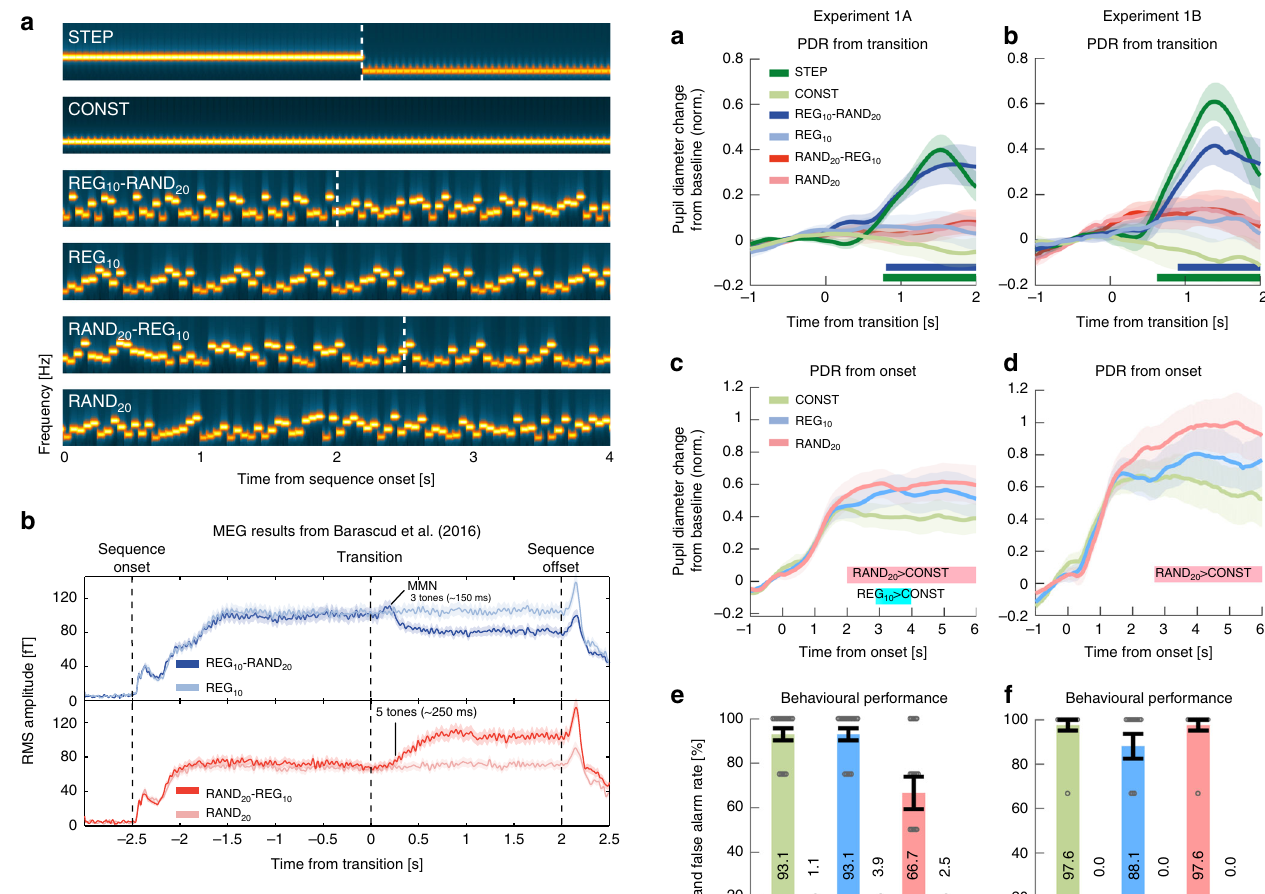
Fig. 1 Basic stimuli and brain responses recorded with MEG. a The stimuli were sequences of concatenated tone-pips (50ms) with frequencies drawn from a pool of 20 fi xed values. The tone-pips were arranged according to six frequency patterns, generated anew for each subject and on each trial: CONST sequences consisted of a single repeating tone; STEP contained a step change from one tone frequency to another; REG 10 sequences were generated by randomly selecting 10 frequencies from the pool and iterating that sequence to create a regularly repeating pattern; RAND 20 were generated by randomly sampling from the full pool with replacement; REG 10 -RAND 20 and RAND 20 -REG 10 sequences contained a transition between a regular and random pattern or vice versa. Transition times (between 2.5 and 3.5s post onset) are indicated by a white dashed line. In RAND 20 -REG 10 sequences, the transition time is de fi ned as occurring after the fi rst full regularity cycle, i.e. once the transition becomes statistically detectable. For presentation purposes only, the plotted sequence lengths are equal. Durations varied randomly between 5 and 7s. b Brain responses ( n = 13) to REG 10 -RAND 20 (top panel) and RAND 20 -REG 10 (bottom panel), together with their no- change controls, recorded with magnetoencephalography (MEG). Plotted is Root Mean Square (RMS) over channels, as an estimate of instantaneous power. The fi gures show the entire stimulus epoch, relative to the transition. Shaded areas are ±1 SEM. The transition from RAND to REG is associated with a gradual increase in sustained power from ~250ms (5 tones) post transition. The transition from REG to RAND evokes an MMN-like response (at ~150ms after the transition) followed by a sharp drop in the sustained response. These changes in power are hypothesized to re fl ect the instantiation (RAND-REG) or interruption (REG-RAND) of a contextual top- down model. See Barascud et al. 22 for more details. See also Supplementary Figure 1 for an information theoretic 28 characterization of the stimuli: the REG- RAND transition evokes an immediate increase in information content (IC) of post-transition tones. In contrast, because any REG pattern is equally likely under RAND, a gradual decrease in IC is seen for RAND-REG transitions as the model ‘ discovers ’ the predictable structure within the